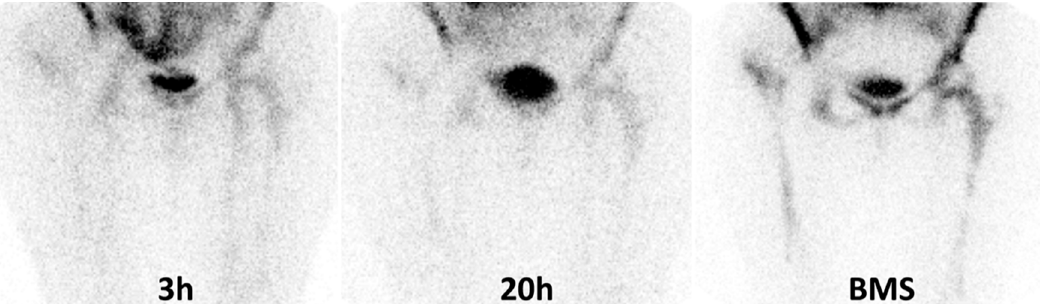
Figure 3. These images show an example of false negative BMS in a patient with histologically confirmed infection of right hip prosthesis. From the left to right: the uptake on the right trochanter at 3 h does not change after 20 h at visual analysis therefore her WBC scintigraphy was classified as doubtful according to criterion “A”. However, we observed an increase of more than 20% at semi-quantitative analysis. The patient performed a bone marrow scan (BMS) (image on the right panel) that showed a congruent uptake with WBC thus excluding the infection. After surgery, an infection by St. Aureus was detected.